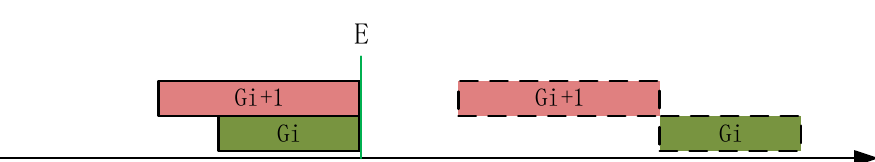
△ t Figure 3. Two groups arrive at the exit successively without congestion. Situation 2. Two groups depart at the same time and arrive at the exit at the same time, causing congestion Group Gi and group Gi + 1 reach the emergency exit at the same time, namely 𝑡 𝑝𝑖 = 𝑡 𝑝𝑖+1 , as shown in Figure 4. In order to avoid the congestion of Gi and Gi + 1 at the emergency exit, one of them can start to escape immediately while the other must delay its departure time and wait at origin. To find the shortest total evacuation time, the delay time should ensure that the two groups pass through the emergency exit successively, and at the same time there is no time interval when they pass through the exit. There are two evacuation solutions to be discussed: 1.